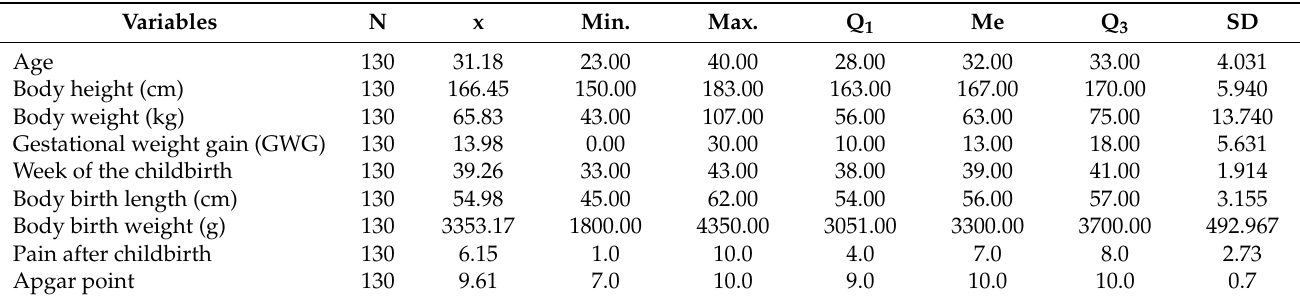
Table 1. Characteristics of the study